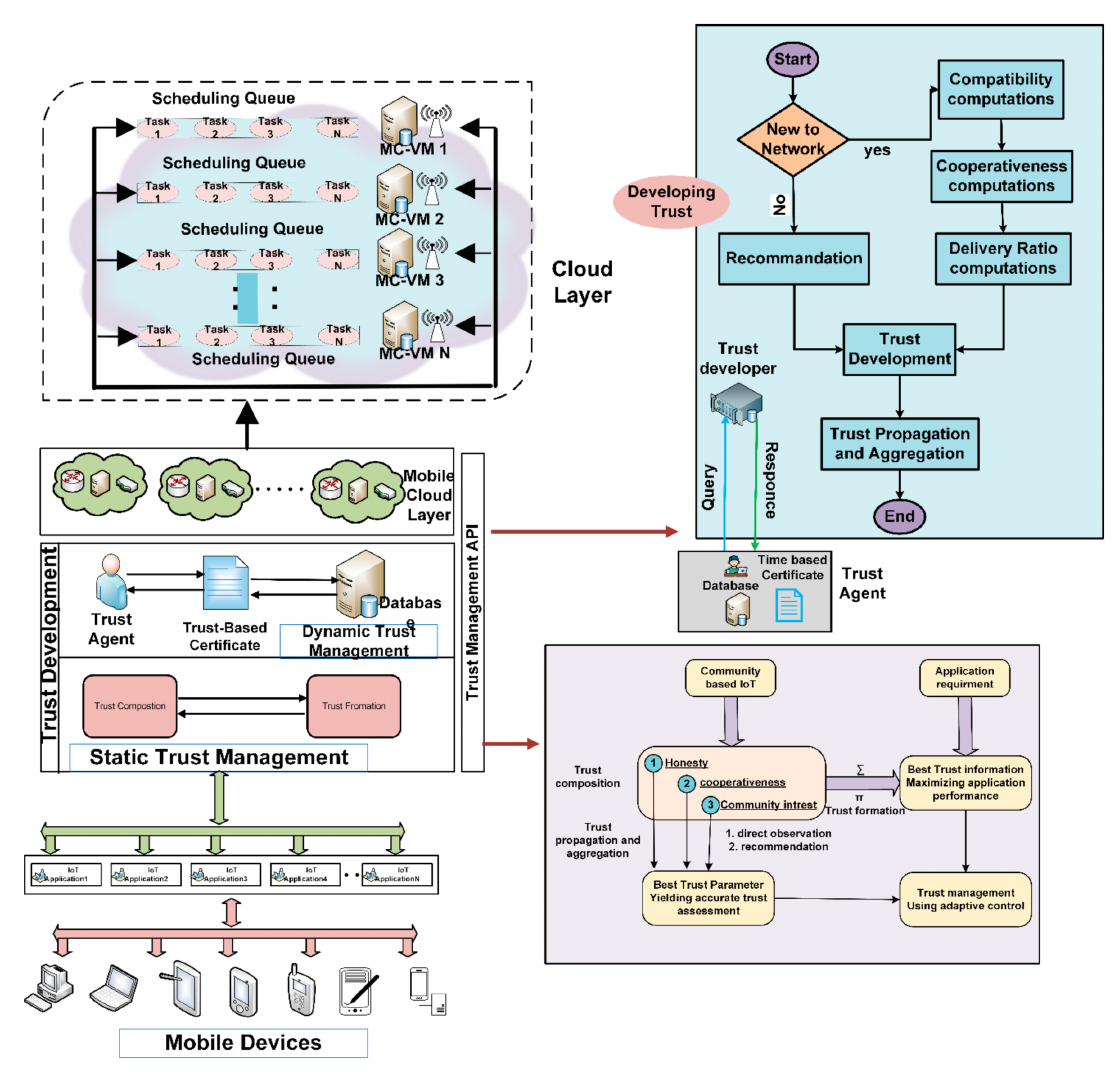
Figure 7. Trust development and task scheduling for mobile cloud